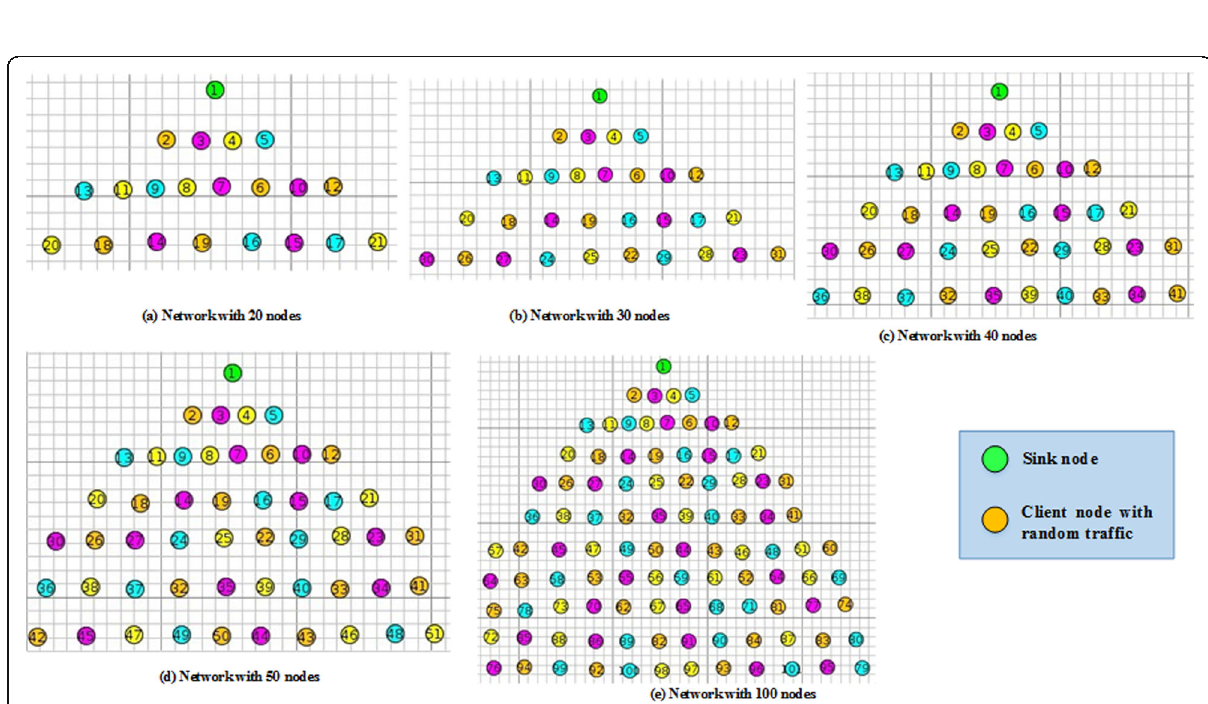
Fig. 5 Scenario I: RPL routing topology with fixed heterogeneous traffic